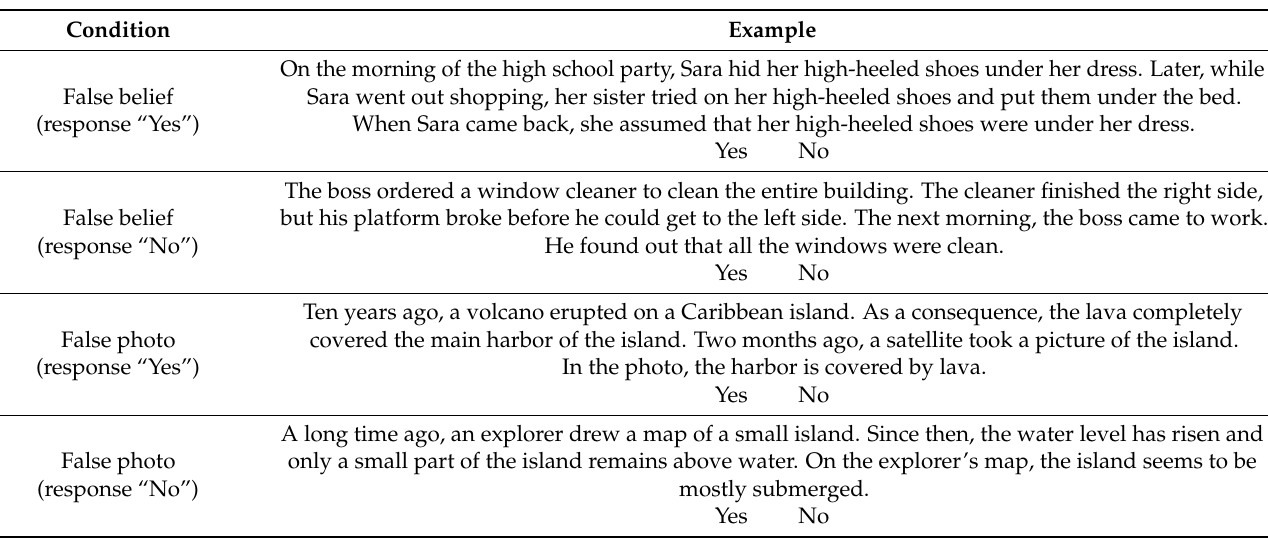
Table 1. Examples of false belief and false photograph